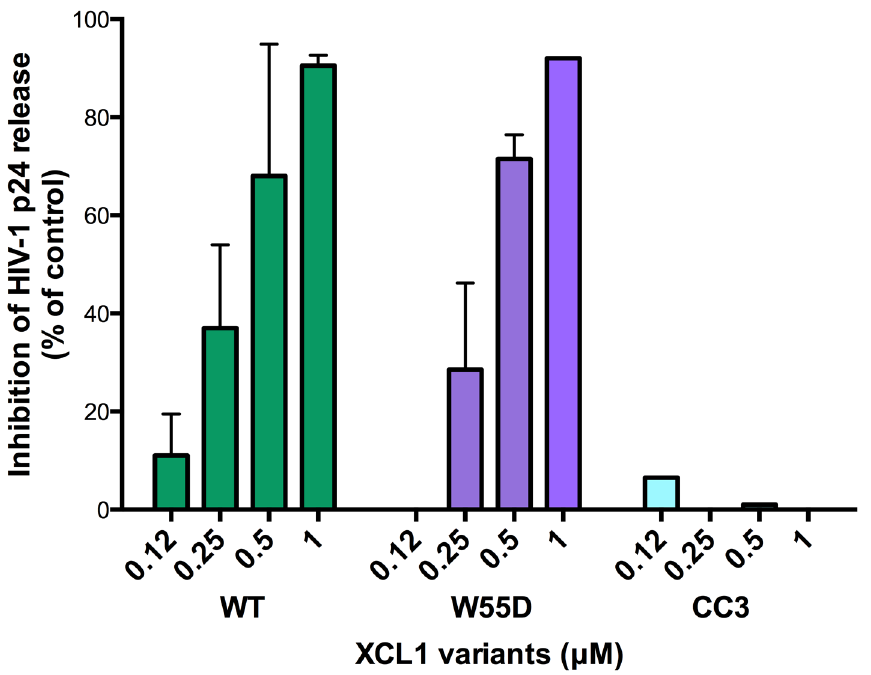
Figure 3. The inhibitory structure of XCL1 against HIV-1 is the all- b , alternatively-folded conformation. Dose-dependent inhibition of an XCL1-sensitive primary HIV-1 isolate (92HT599; X4/R5) by recombinant wild type (WT) XCL1 (green bars), and two stabilized structural variants: W55D, a variant preferentially adopting the all- b /alternatively-folded structure (purple bars), and CC3, a variant locked in the classical chemokine-folded structure (light blue bars). Virus replication was assessed by measuring the amount of p24 Gag antigen in PBMC supernatants via AlphaLISA immunoassay. Data were normalized to the amount of viral replication observed in control cultures (not treated with XCL1). Data represent the mean values ( 6 SD) of replicate wells, representative of at least 3 independent experiments performed on separate PBMC